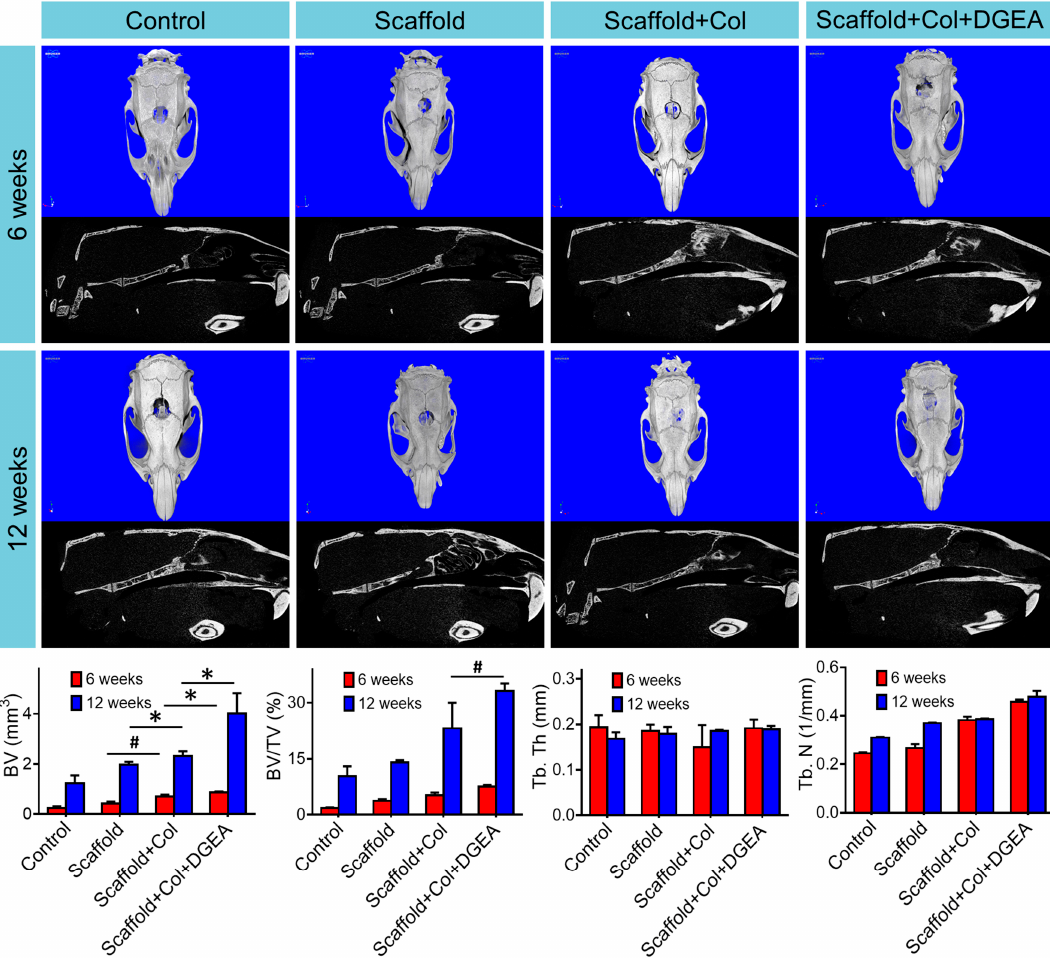
Figure 3. 3D reconstruction of skull bones using micro-CT and semi-quantitative analyses of skull defect sites ( n = 5; * p < 0.05, # p < 0.01).